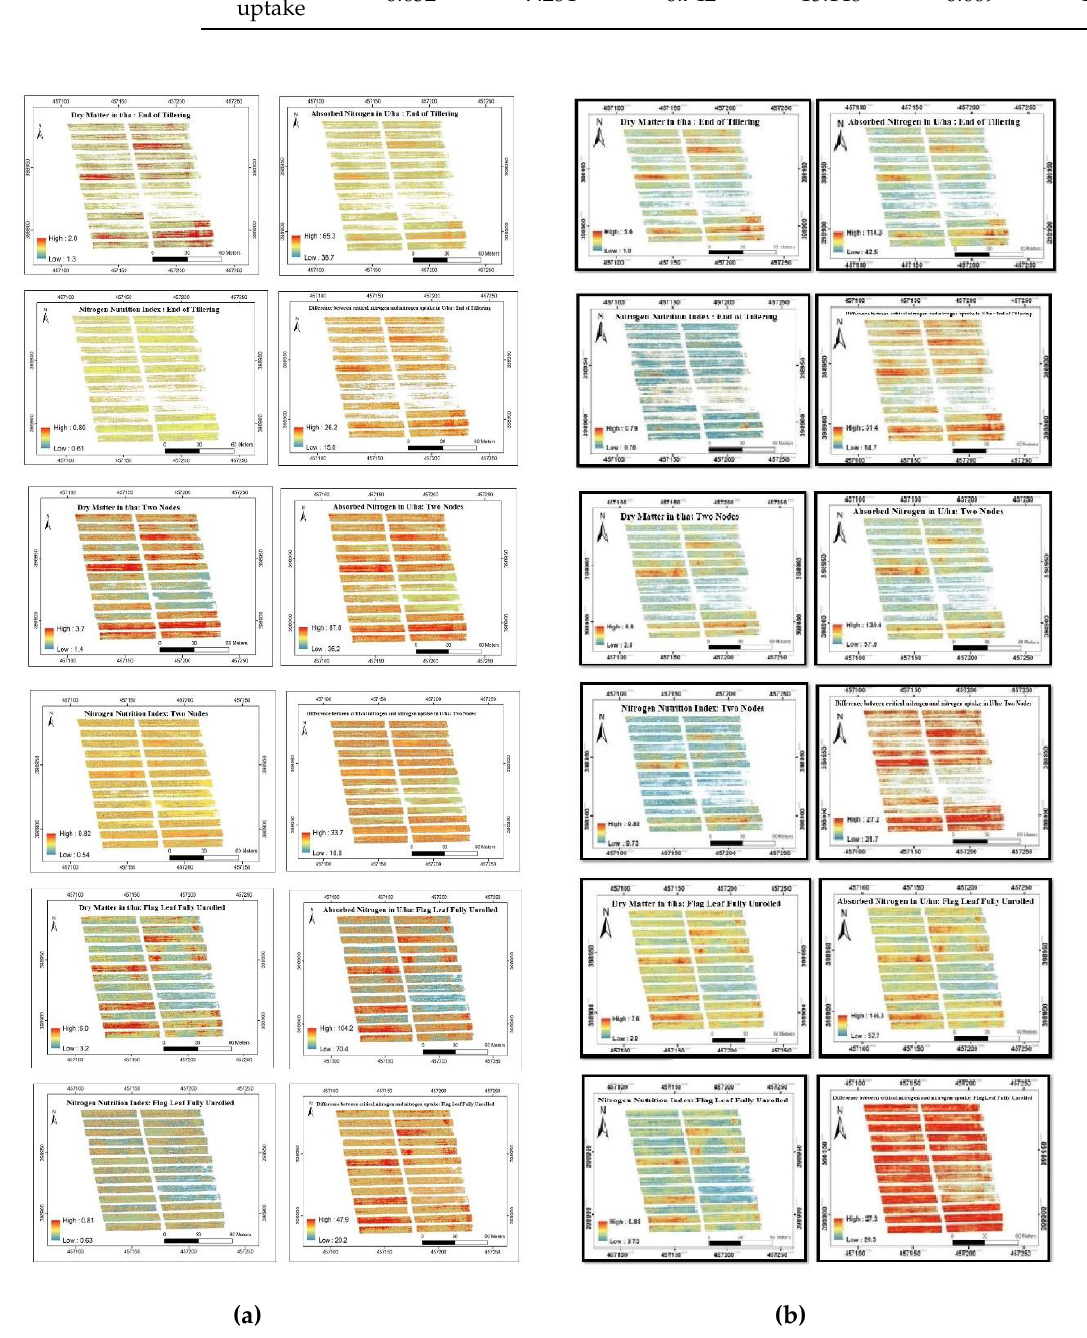
Figure 12. Dry matter, nitrogen uptake, NNI, and difference between critical nitrogen and nitrogen uptake maps during end of tillering, two nodes and last leaf flag unrolled using ( a ) linear regression and ( b ) using Random forest.